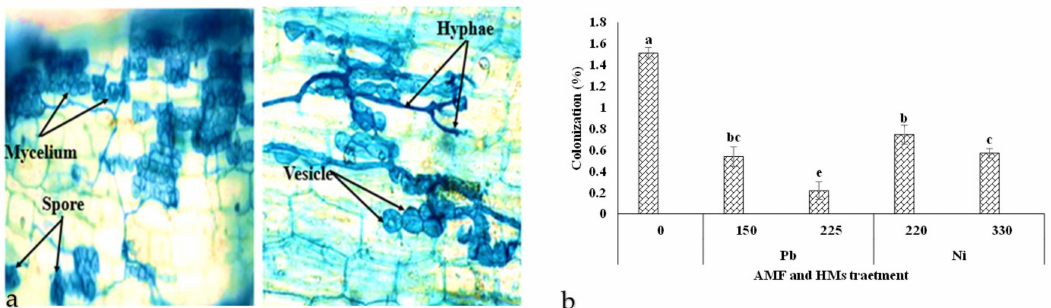
Figure 1. Microscopic images of the stained lavender roots to detect the arbuscular mycorrhiza (Funneliformis mosseae) colonization ( a ). The effect of arbuscular mycorrhizal fungi (AMF) on root colonization under Pb (mg kg − 1 soil) and Ni (mg kg − 1 soil) heavy metals (HMs) stress ( b ). Different letters indicate significant differences according to the LSD test at p < 0.05.